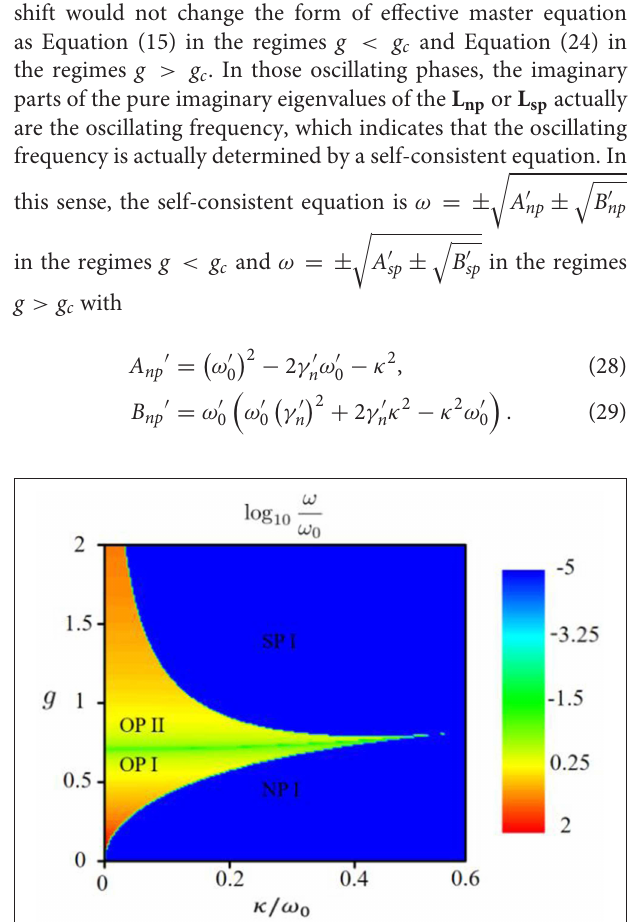
FIGURE 3 | The oscillating frequencies in the oscillating phases I and II. Obviously, the oscillating frequencies is zero in the normal phase I and superradiant phase I. When the decay rate κ is fixed and the coupling strength g increases, it increases in the OP I while decreases in the OP II. It is discontinuous at the transition edge from the oscillating phases to the normal phase I or superradiant phase